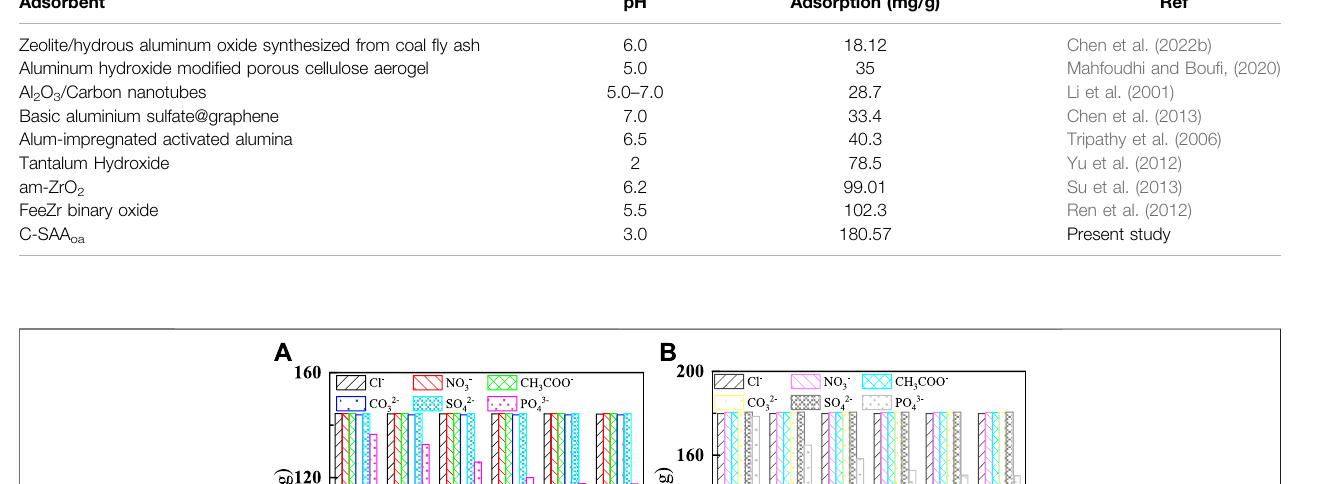
TABLE 4 | Comparison of the adsorption capacity of fl uoride by C-SAAoa with other adsorbents. Adsorbent